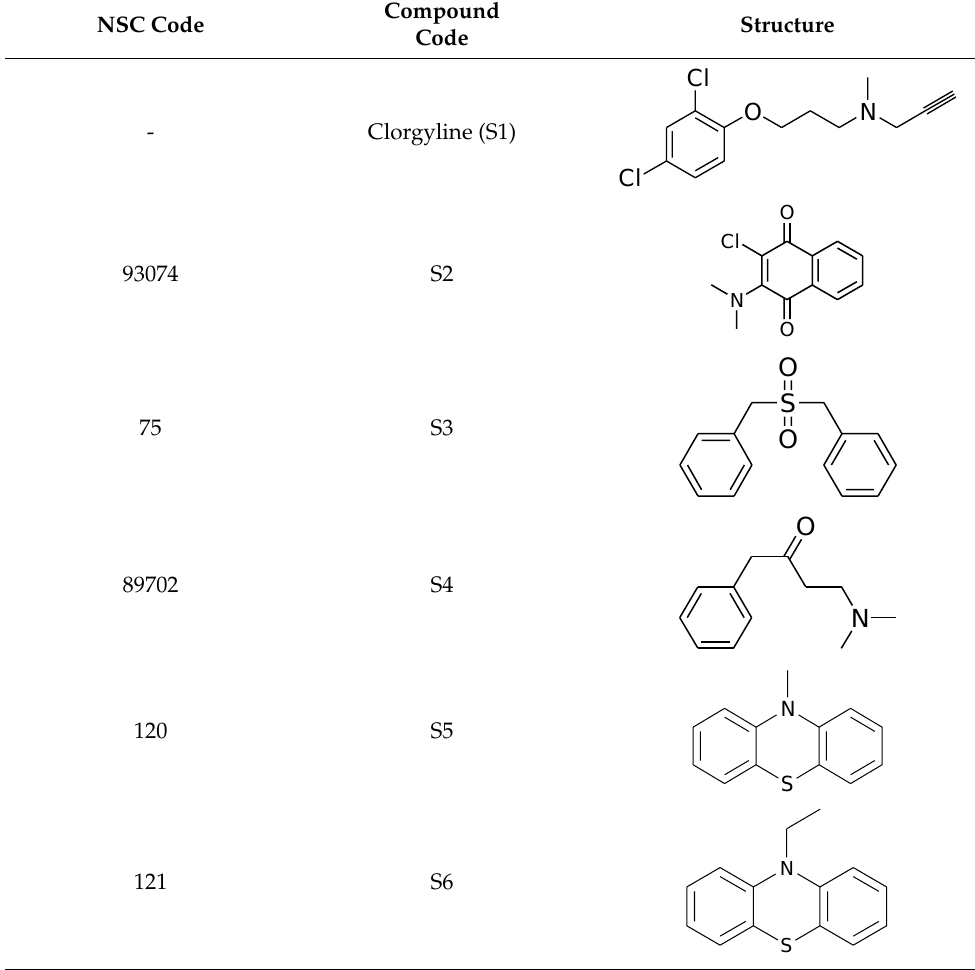
Table 4. Hits obtained by ligand- and structure-based drug design approaches. The chemical structure of hits was retrieved from NCI database. Hits have been provided by NCI agency.